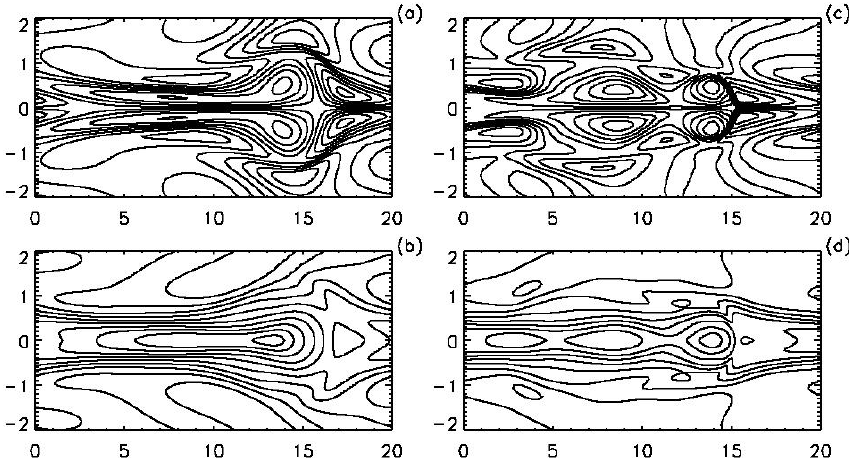
Fig. 10. Contour plots of both potential temperature and horizontal velocity for the deep domain initialized with the Doppler duct depicted in Fig. 10. Panels (a) and (c) depict potential temperature contours at two different times during the evolution and panels (b) and (d) depict the coincident horizontal velocity field.